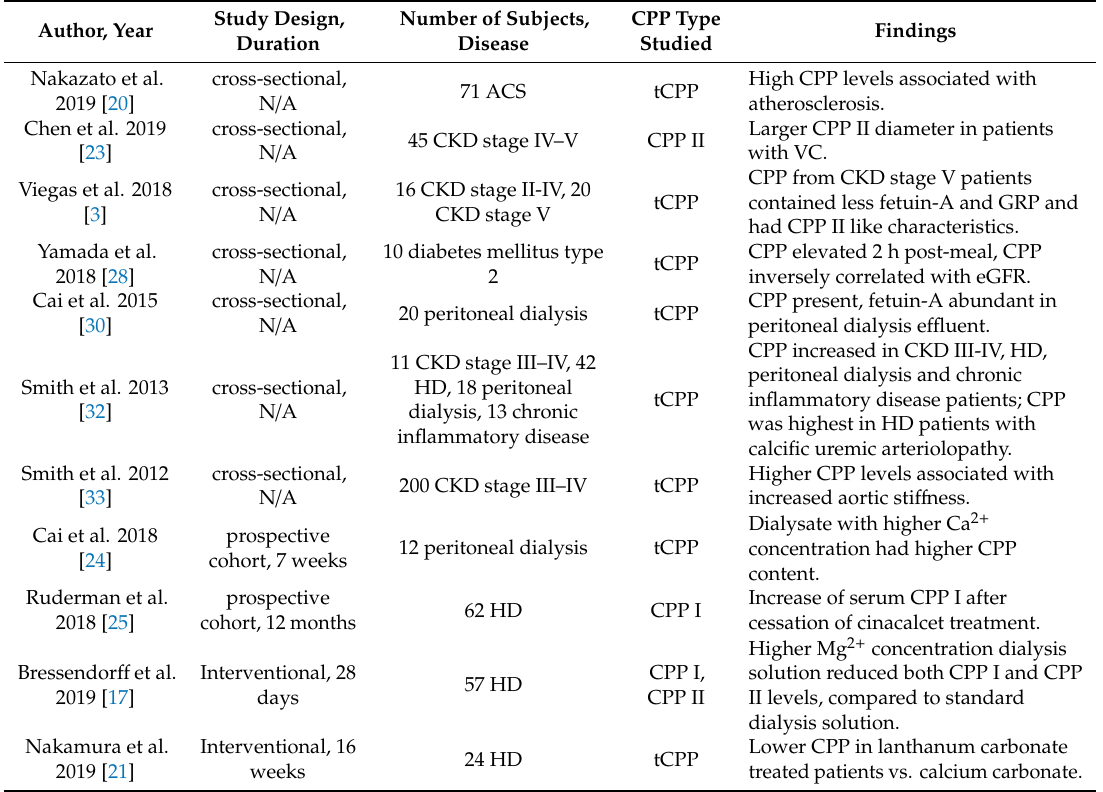
Table 1. Summary of 11 human studies on calciprotein particle